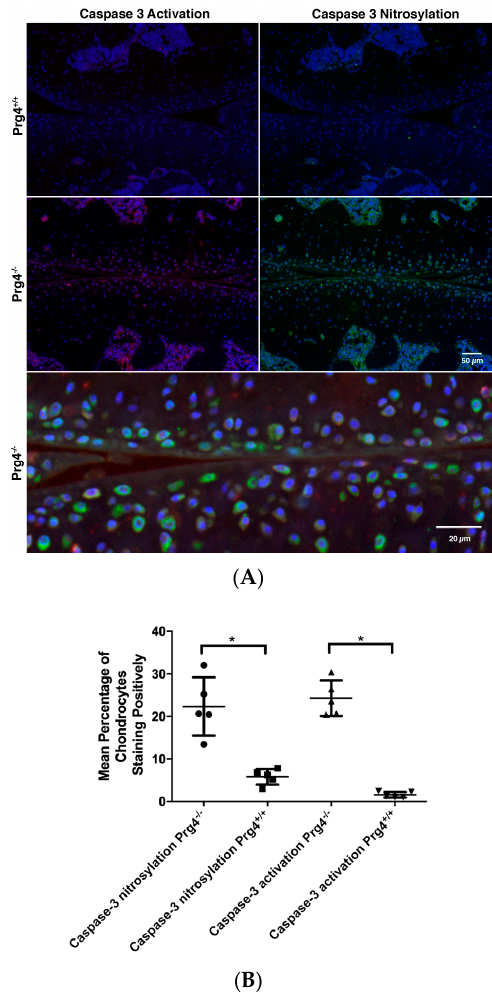
Figure 5. Immunohistochemistry of tibio-femoral joints from Prg 4 − / − and Prg 4 +/+ mice for caspase-3 activation and nitrosylated Cys163 of caspase-3: ( A ) Most immunopositivity of chondrocytes is located just beneath the articular surface. Both immunoprobes competed for adjacent epitopes within the active cleft of caspase-3 which upon dual probing merged both immunofluorescent stains within chondrocytes (scale bar is 20 μ m); ( B ) Semi-automated counting of DAPI counterstained chondrocytes from the cartilage surface to the tide mark revealed significantly higher numbers of immunopositive cells for activated caspase-3 ( ) and caspase-3 nitrosylation ( ● ) in Prg 4 − / − as compared to Prg 4 +/+ cartilage respectively ( , ), *p<0.05 (scale bar is 50 μ m).